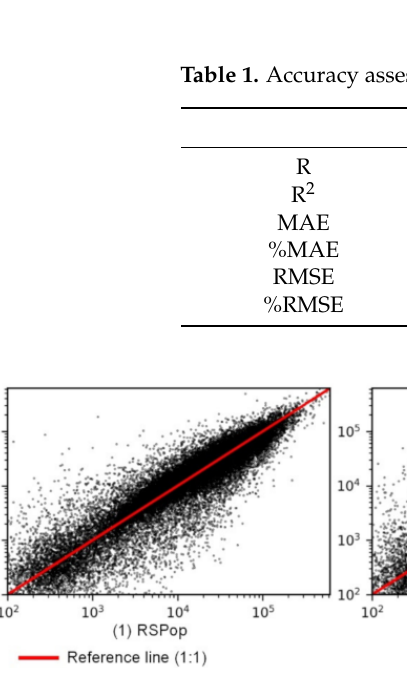
Figure 10. Scatterplots of the true population count and estimated population count from RSPop, WorldPop, and GPWv4 at town scale.